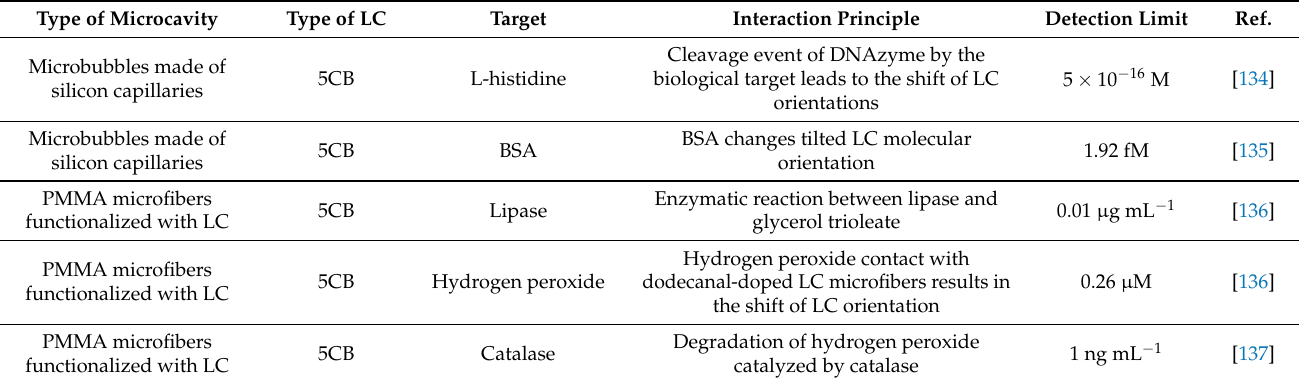
Table 2. Summary of WGM microcavities of LC biosensors used in detecting